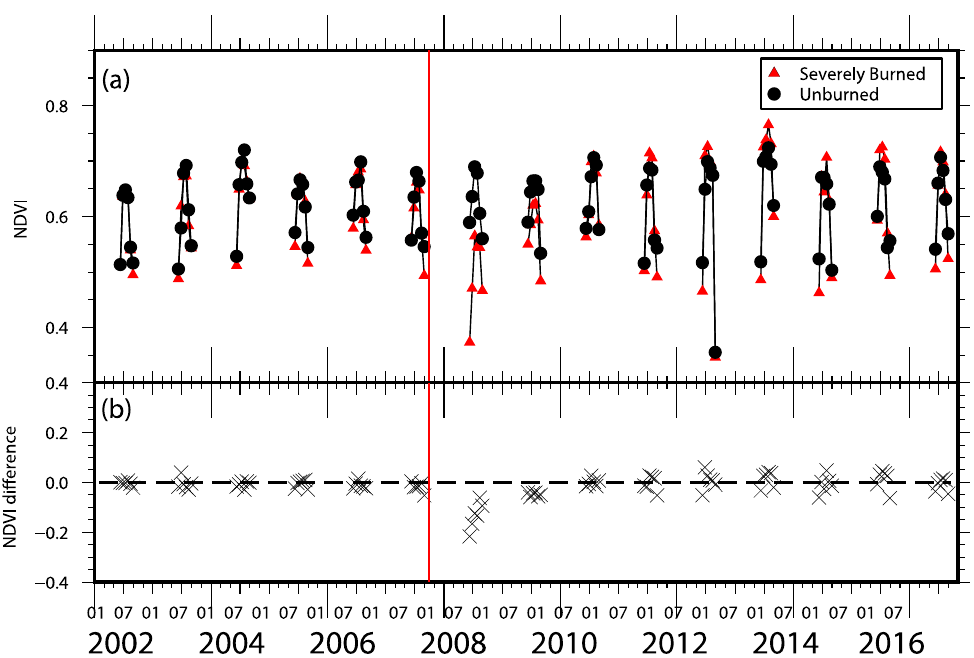
Figure 5. Time series of NDVI at the severely burned and unburned sites ( a ) and their differences ( b ) severely burned minus unburned. The vertical red line marks the end of the ARF.